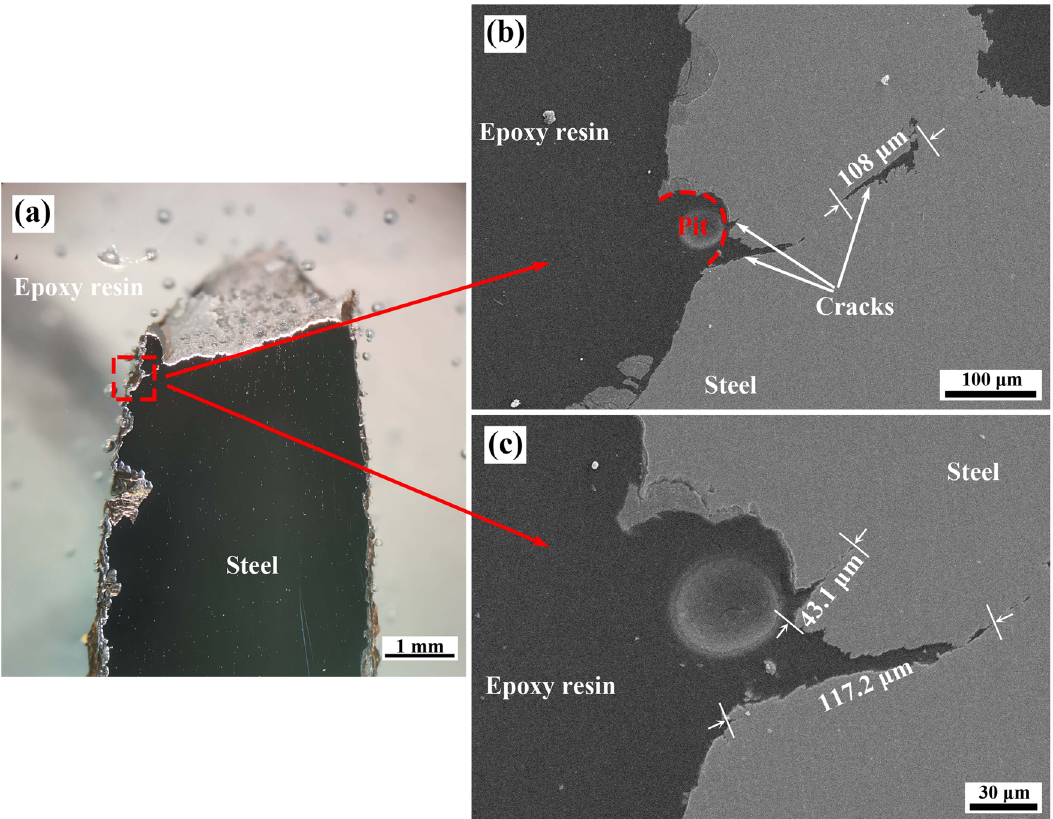
Fig. 12 Cross-sectional morphologies of the fractured tensile sample placed at the HTL. a OM image and b , c SEM images. SEM images show the cracks initiated at the corrosion